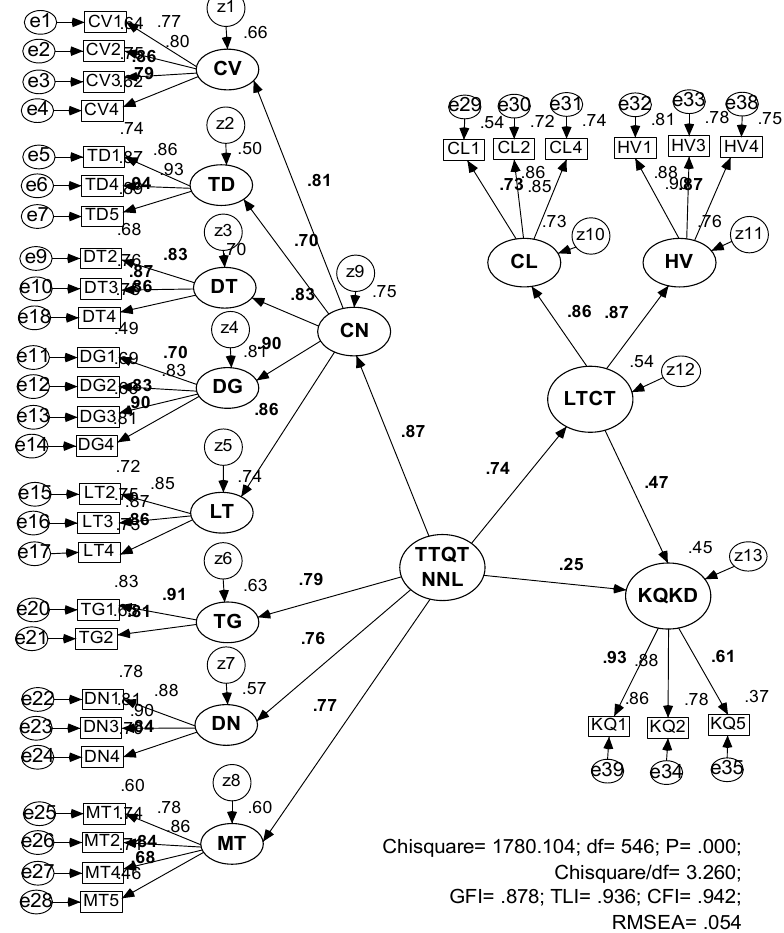
Fig. 6. SEM results of formal (standardized) theoretical model ( Source: Author’s estimation from survey data )